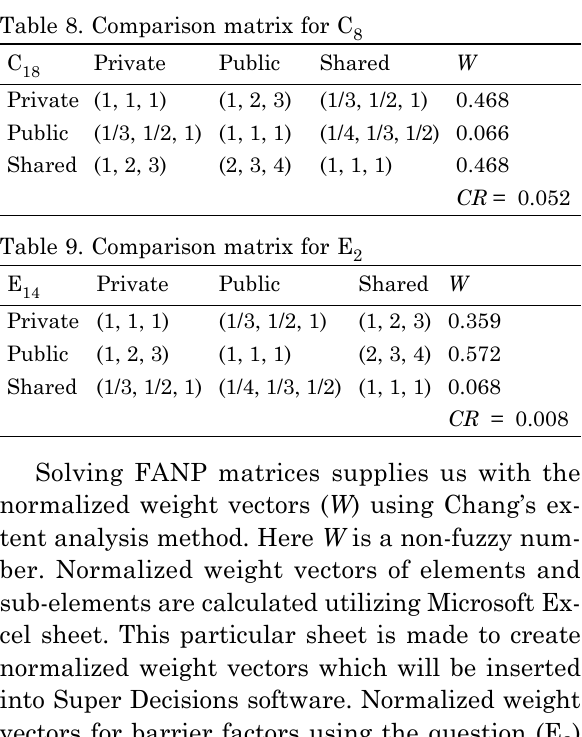
Table 8. Comparison matrix for C